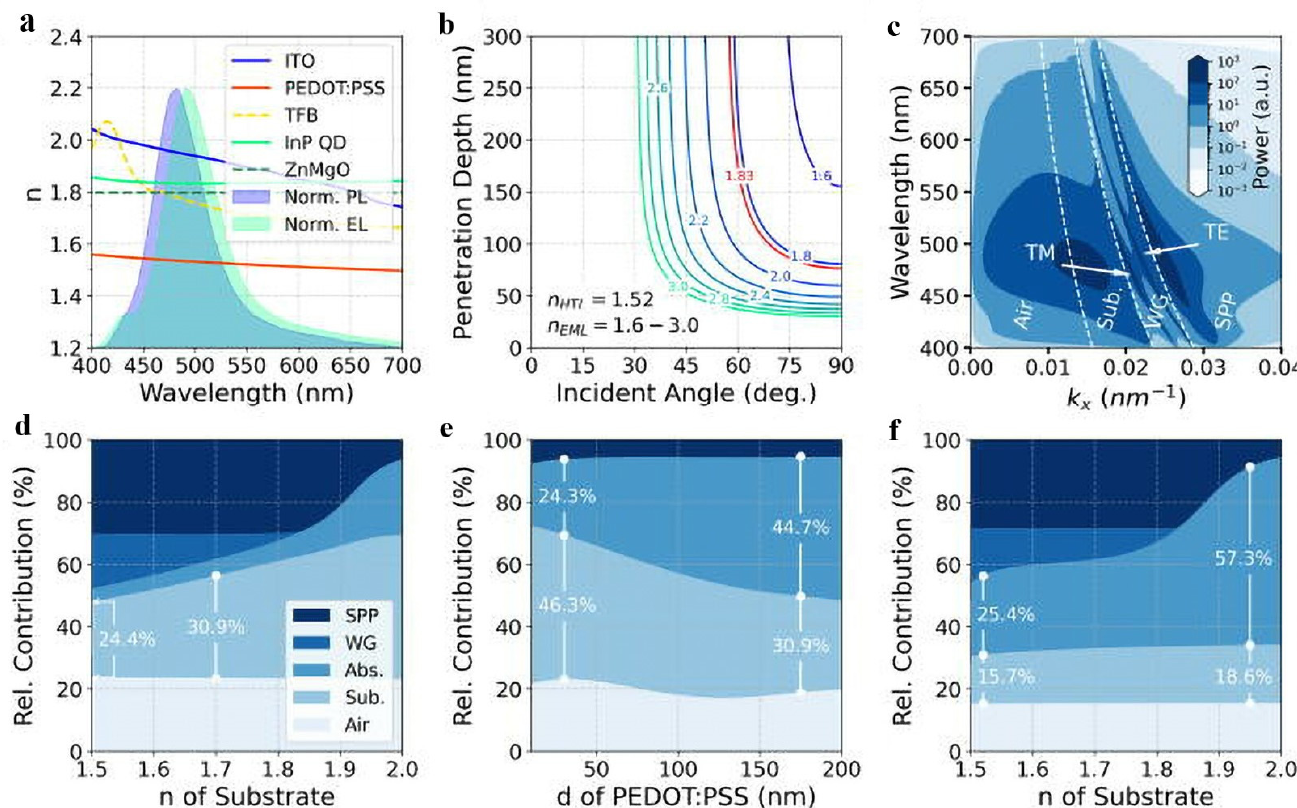
Figure 16. ( a ) The refractive indices of the QLED materials, the normalized PL spectrum of the InP QD, and the EL spectrum of the InP QLED. ( b ) Penetration depth of the evanescent wave vs. angle of incidence for varied refractive index of EML at wavelength of 488 nm. ( c ) Power dissipation spectrum of the InP QLED; dashed lines separate the regions of different optical modes. Optical power distribution of different optical modes ( d ) vs. refractive index of the substrate at PEDOT:PSS thickness of 30 nm, ( e ) vs. PEDOT:PSS thickness at refractive index of the substrate of 2, and ( f ) vs. refractive index of the substrate at PEDOT:PSS thickness of 600 nm. Reprinted with permission from Ref. [26]. © AIP Publishing.